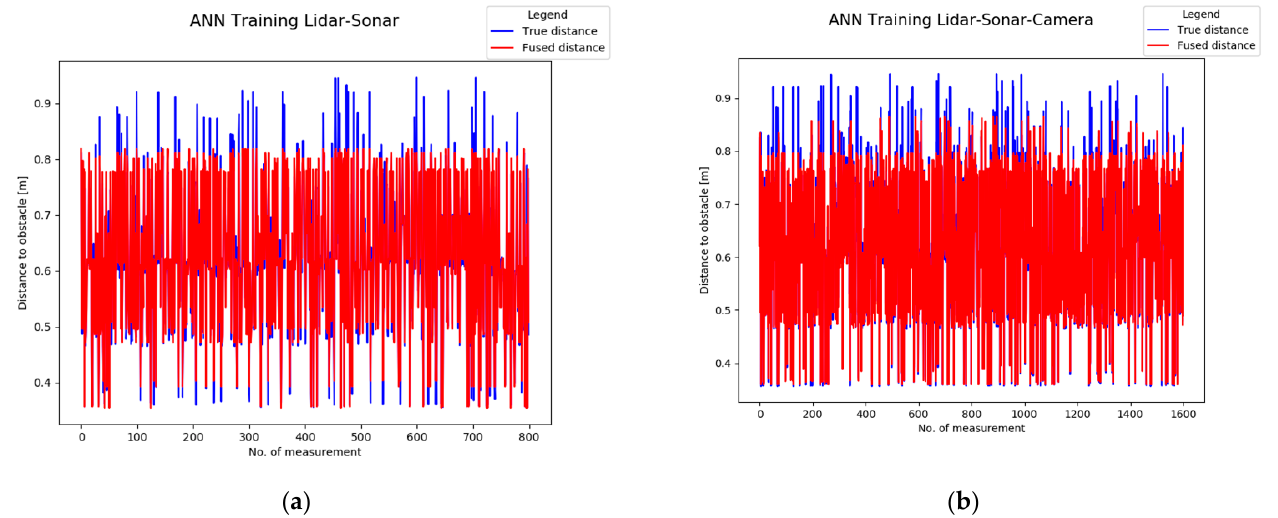
Figure 37. Validation of neural network with randomized data for: ( a ) LiDAR-Sonar model; ( b ) LiDAR-Sonar-Camera model.